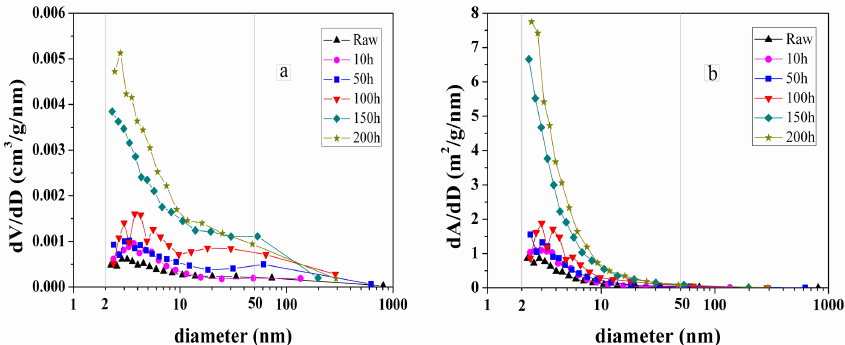
Figure 7. ( a ) Pore size distribution and ( b ) specific surface area of raw sample and spent samples extracted by sub-critical water at 350 ◦ C for different